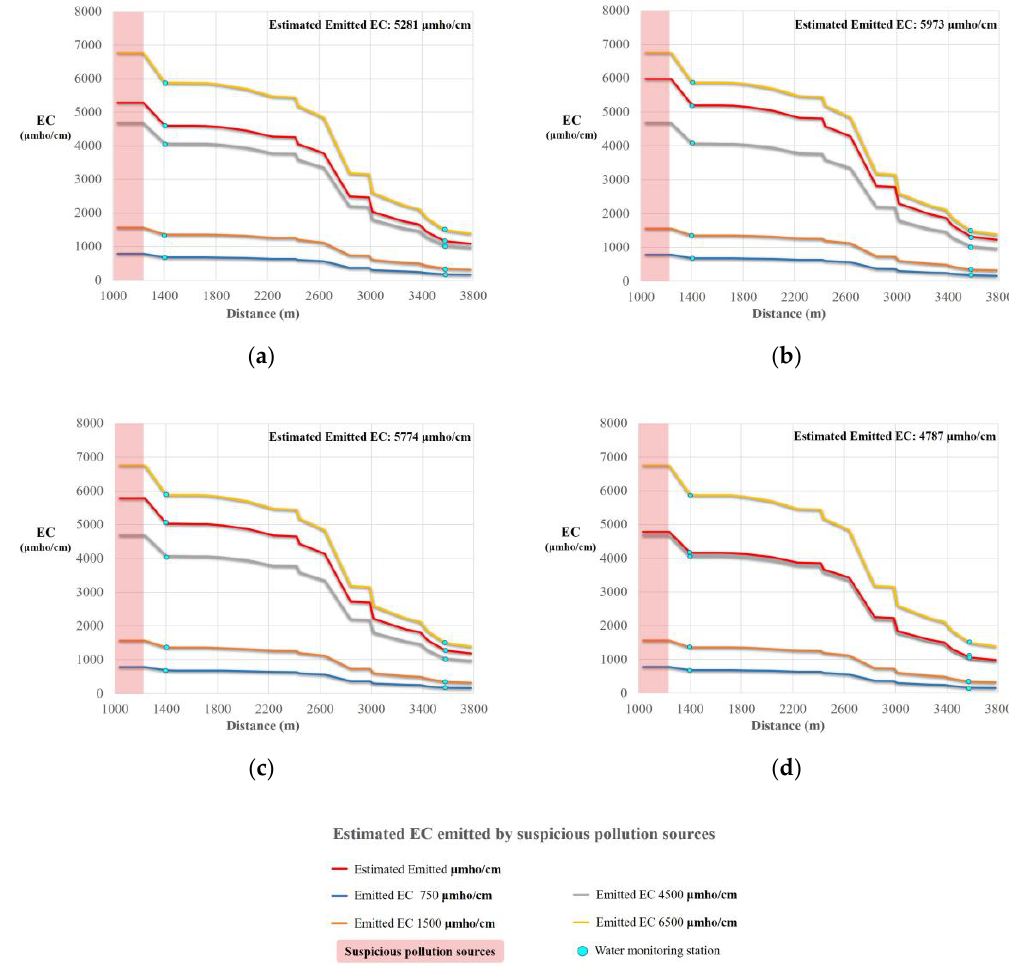
Figure 9. Reverse prediction of EC concentrations along the channel for each case at heavy metal monitoring station M02 ( a ) 5080 µ mho / cm; ( b ) 5746 µ mho / cm; ( c ) 5560 µ mho / cm; ( d ) 4610 µ mho /